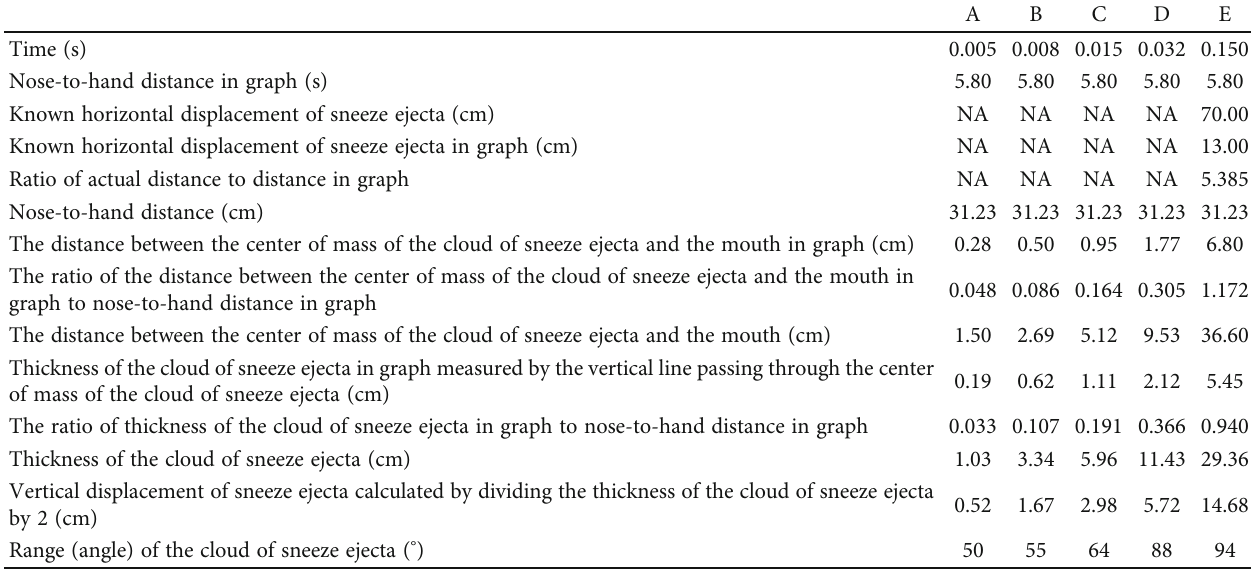
Figure 2: Figure 3 from Scharfman et al. Table 1: Data extracted from Scharfman et